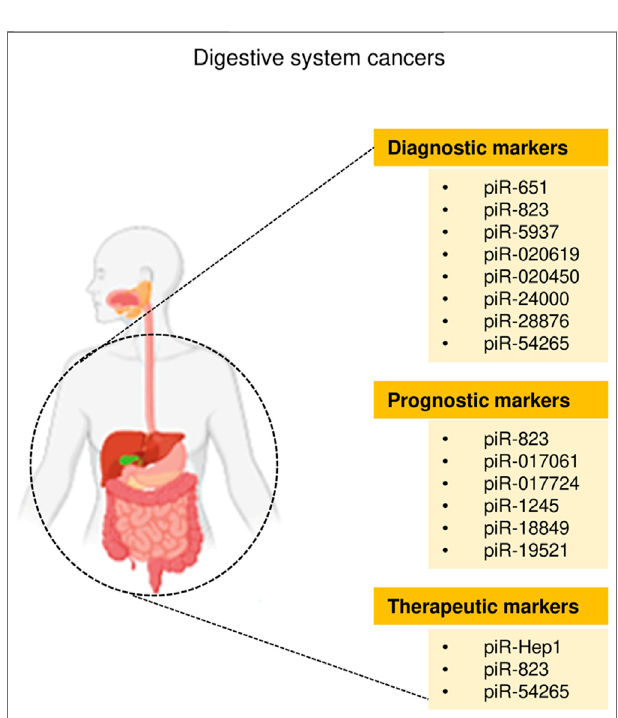
FIGURE 3 | The clinical application of piRNAs in digestive system cancers.